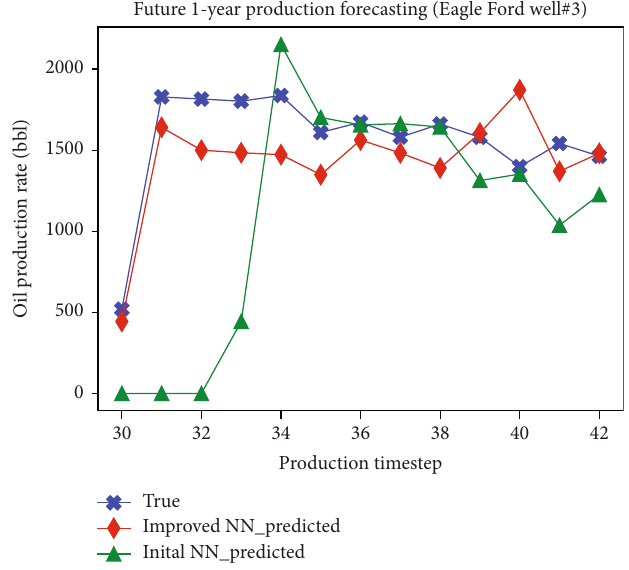
Figure 11: 1-year oil rate prediction of the DNN system.